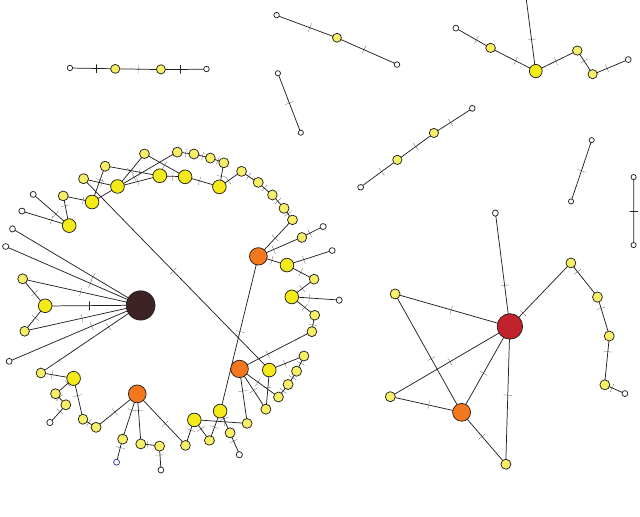
Figure 3. Self-organized network evolved in the adaptive model. Nodes represent agents, while each link represents a non-vanishing cooperative interaction. The small dash on the link is a fairness indicator: the further it is shifted toward one agent, the lower is the fraction of the total investment into the cooperation that he contributes. Nodes extracting more payoff are shown in darker color and are placed toward the center of the community. The size of a node indicates the total investment the agent makes. In the final configuration all links within a BCC receive the same total investment and all nodes of the same degree make the same total investment. Simulation parameters: ρ = 0 . 7 , τ = 0 . 1 , µ = 2 . 24 , ν = 0 .